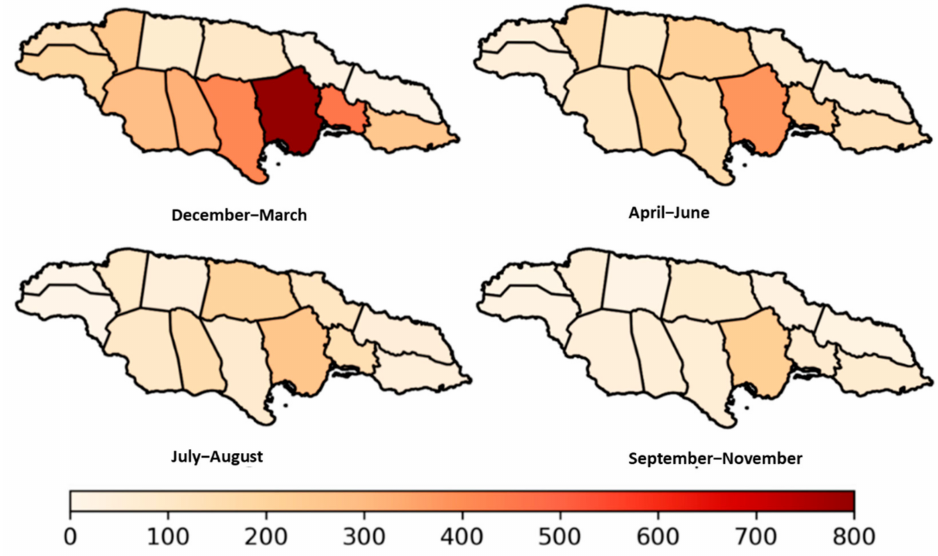
Figure 8. Distribution of Fire Frequencies by seasons for